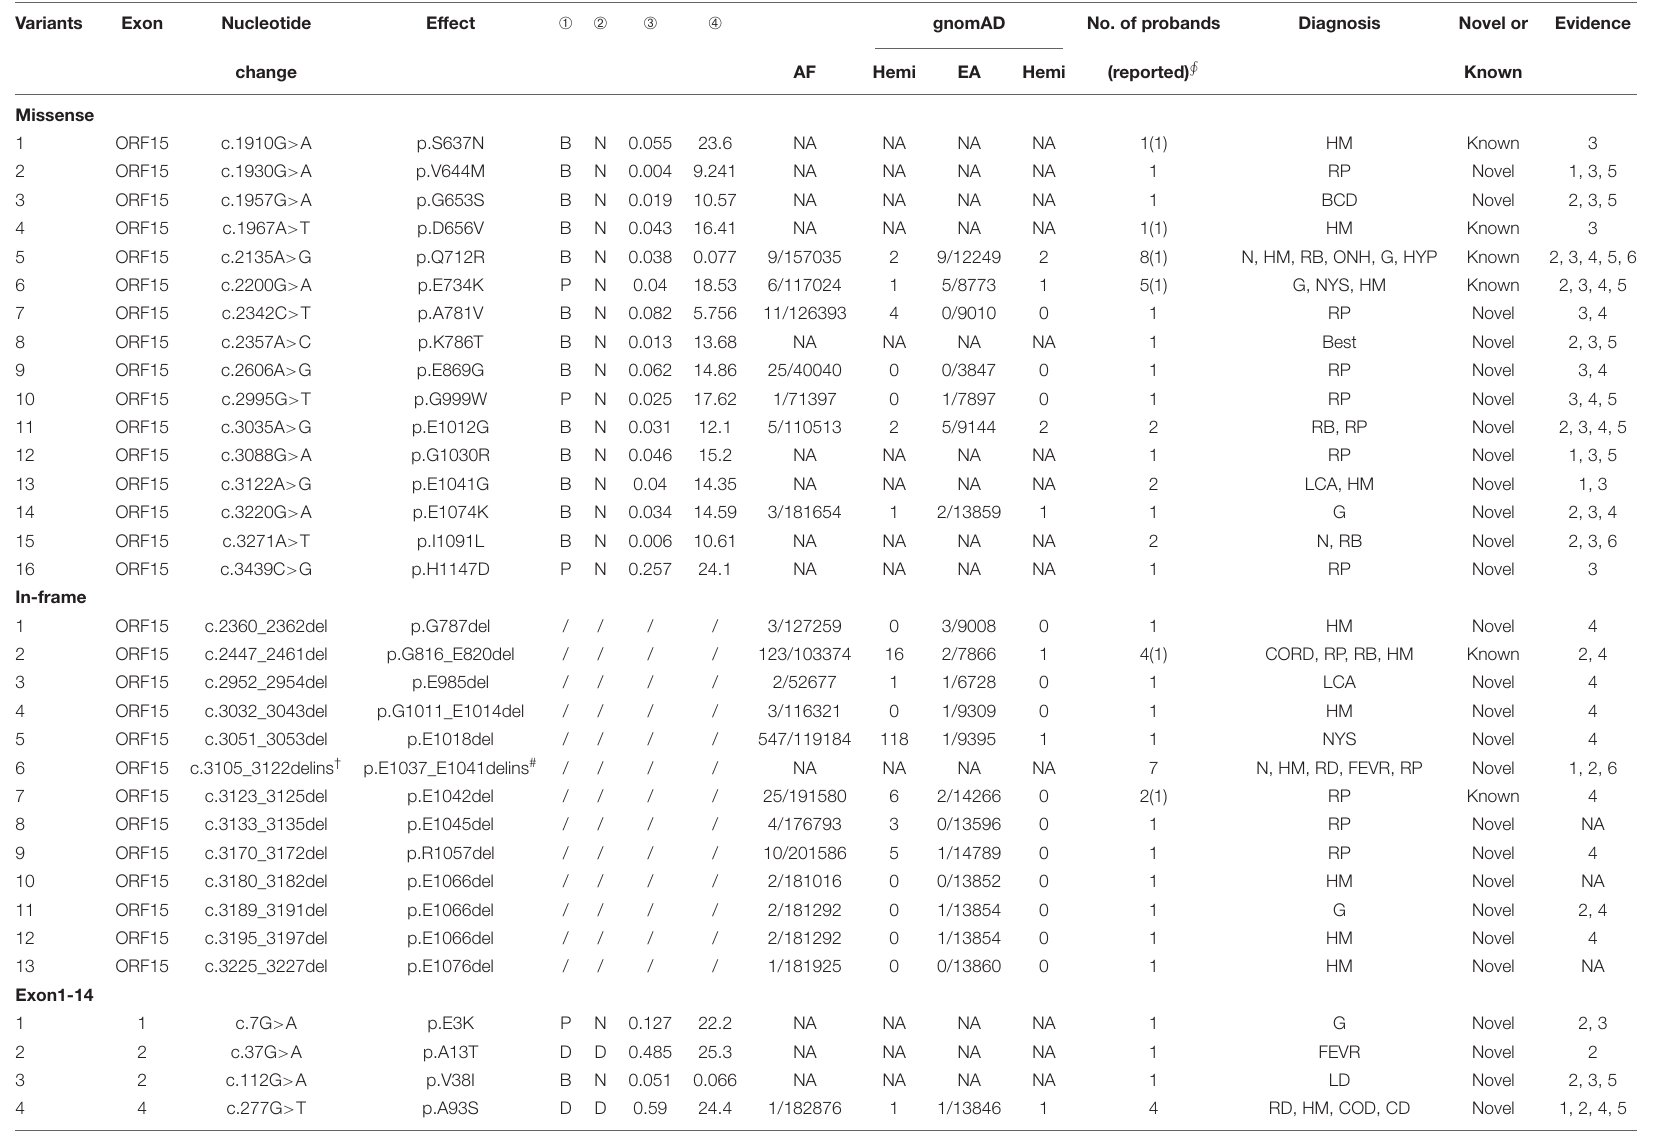
TABLE 2 | 51 benign or likely benign variants in RPGR from 101 unrelated families (based on